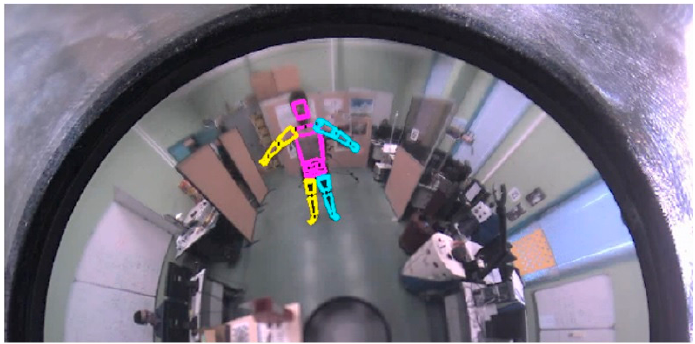
Figure 3. 3D human body model projected on the omnidirectional image. The geometrical model of the Catadioptic sensor has been taken into account in the projection process.